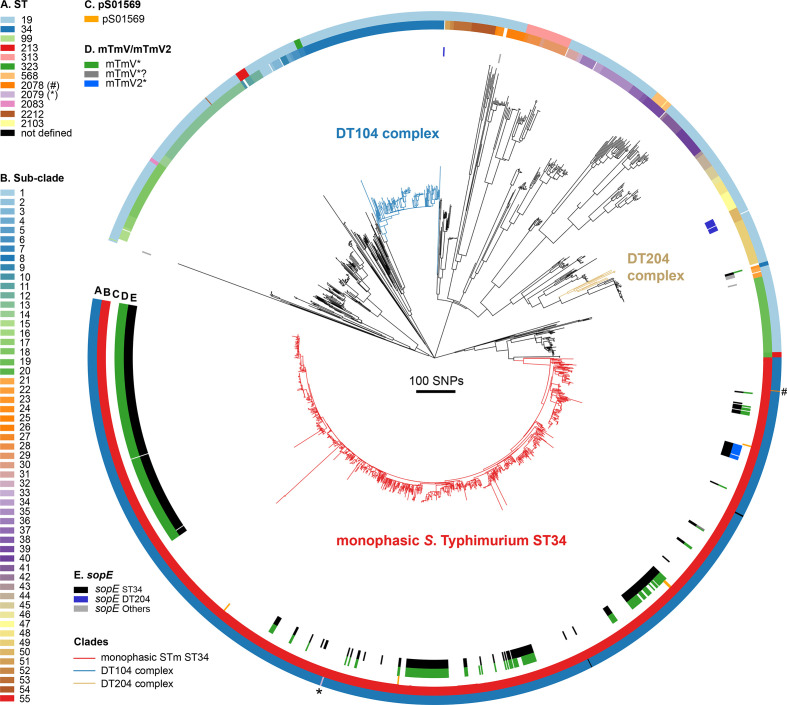
Population structure of S. Typhimurium from human clinical cases of infection in England and Wales and distribution of sopE. ML phylogenetic tree of S. Typhimurium and monophasic S. Typhimurium isolated from UK human salmonellosis subjects between 2012 and 2016, showing the distribution of the sopE gene, of mTmV/mTmV2 and pS01569 phages, and the population structure based on a root-to-tip SNP-threshold clustering method and ST. The tree is of 1697 
S
.
enterica
 Typhimurium and monophasic S. Typhimurium isolates from UK clinical infections and was generated using core-genome SNPs identified with reference to S. Typhimurium SL1344. The circles represent (A) the ST, (B) epidemiologically relevant phylogroups using a root-to-tip distance threshold of 150 SNPs, (C) the distribution of the prophage plasmid pS01569, (D) mTmV and related sequences, with poor coverage and/or polymorphisms indicated as mTmV*?, and (E) the distribution of six sopE allelic variants reported as three variables – monophasic S. Typhimurium ST34 allele, S. Typhimurium DT204 complex allele, or one of the four alternative alleles. Four strains within the monophasic S. Typhimurium ST34 lineage were not ST34: two were predicted to be ST2078 and ST2079, which differ by a single-locus SNP from ST34, while the remaining two were of undefined ST.